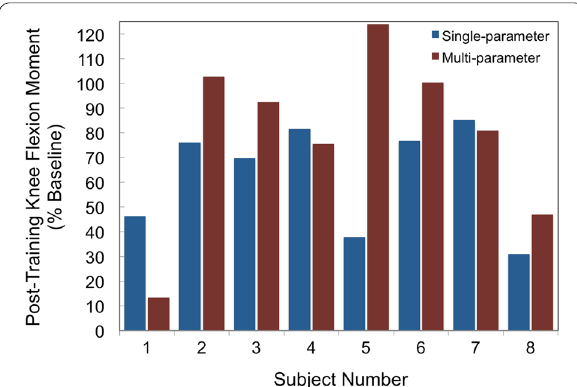
Fig. 4 Knee flexion moment response to model-driven, single- and multi-parameter motion training for individual